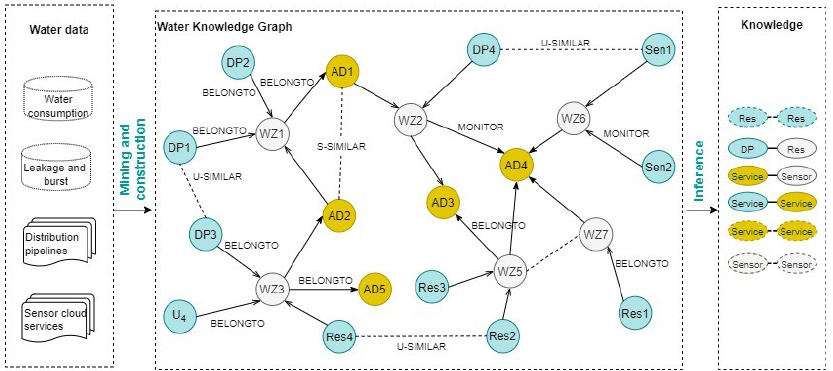
Figure 3. Water knowledge